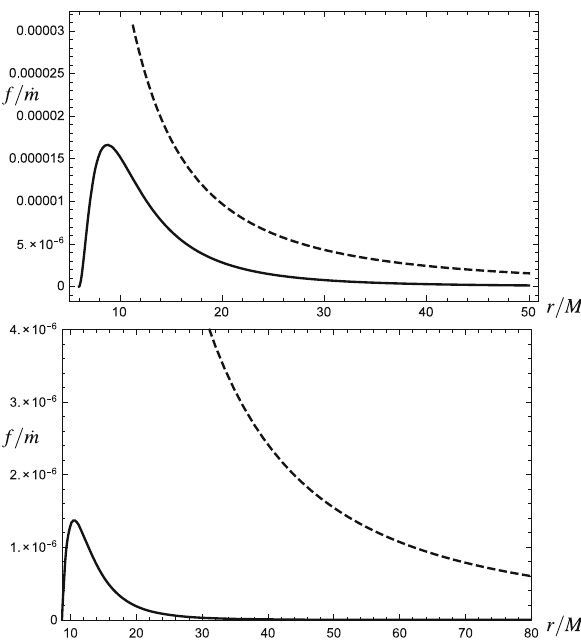
Fig. 2 Top panel Comparison between the luminosity flux from accre- tion disks around a Schwarzschild black hole ( continuous line ) and the luminosity flux from accretion disks inside the Bonnor solution ( dashed line ) with h = − 0 . 000214. The value of the constant h has been chosen in order to have the mass of the Bonnor solution between r 0 and infinity (given by Eq. (12)) equal to the Schwarzschild mass M as measured by observers at infinity. For this particular plot the chosen value of r 0 was r 0 = 0 , 003 M . Bottom panel Comparison of the luminosity flux in the Bonnor space-time ( dashed line ) with a Kerr black hole with a = 0 . 9 ( continuous line ). The value of the ISCO for such a black hole is r (cid:3) 8 . 7 M . Note that the luminosity depends on the location of the ISCO and therefore on the value of a ; however, it is generally lower than the Bonnor case. For h , M and r 0 the values chosen are the same as the ones in the top panel